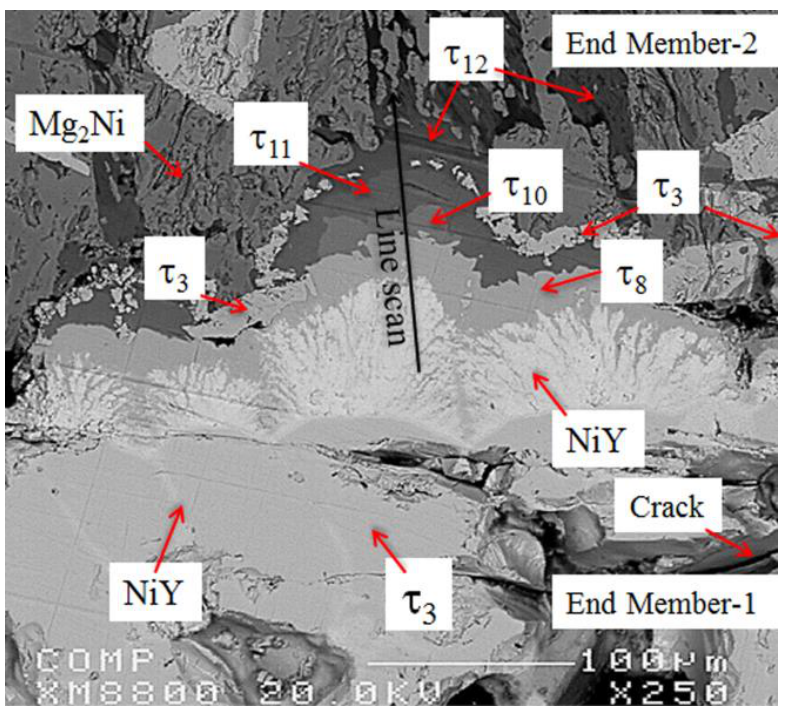
Figure 5. Backscatter electron (BSE) images of the solid–solid diffusion couple 2 annealed at 673 K for 4